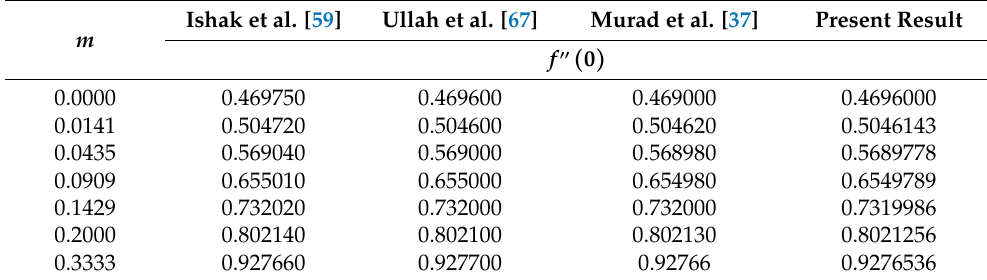
Table 3. Results comparison of f (cid:48)(cid:48) ( 0 ) with different value of m while φ 1 = φ 2 = (cid:101) A = Bi = S = 1.0 and Pr = 0.73. Ishak et al. [59] Ullah et al. [67] Murad et al. [37] m